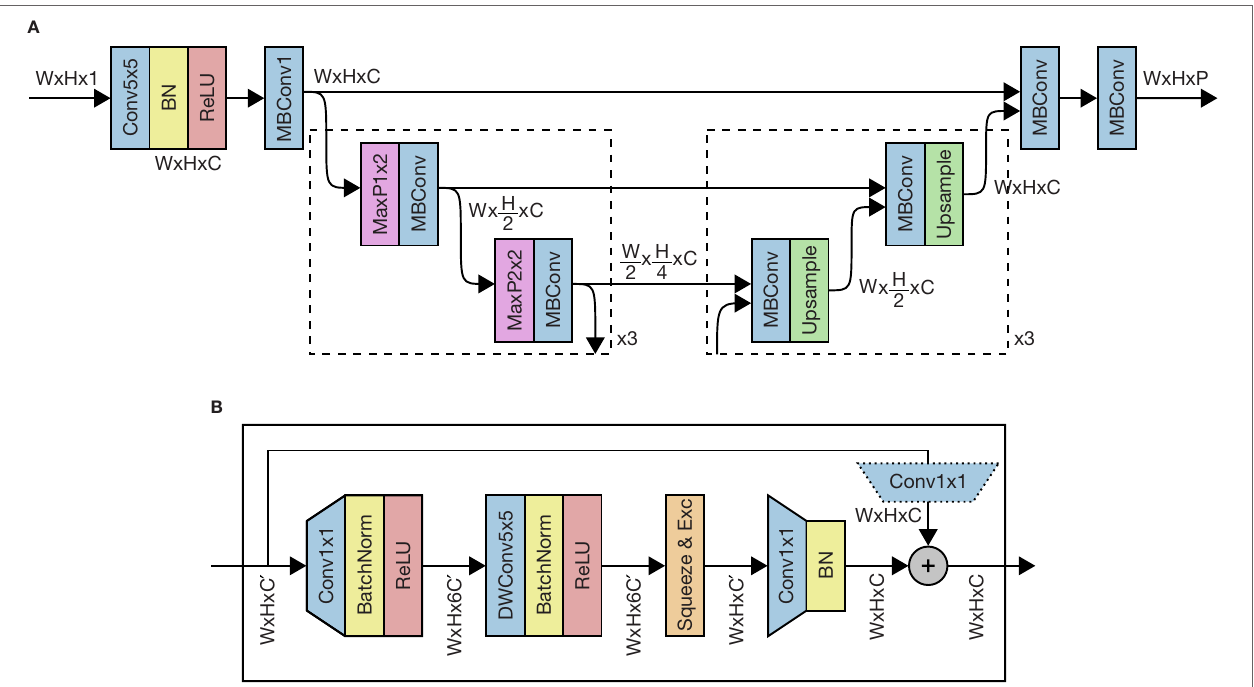
FIGURE 2 | Neural network architecture for the Echofilter model. (A) Main architecture, using an adaptation of the U-Net framework with 6 downsampling blocks, 6 upsampling units, and a single skip connection at each spatial resolution. The network contains a convolutional layer with 5×5 kernel and “same” padding (Conv5x5); BatchNorm (BN); rectified linear unit (ReLU); MBConv blocks (see panel B ); max pooling (MaxP), with either 1×2 or 2×2 kernel and stride; and bilinear upscaling (Upsample) layers. The size of the latent representation of the image as it passes through the network is indicated. We train the network with W =128, H = 512, C = 32. (B) Structure of MBConv block, containing pointwise convolution (Conv1x1), depth-wise convolution (DWConv5x5) and Squeeze & Excite layers. For downscaling blocks C ′ = C, and for upscaling blocks C ′ = 2C. The pointwise convolution on the residual branch is only present for upscaling blocks, where C ′ ≠